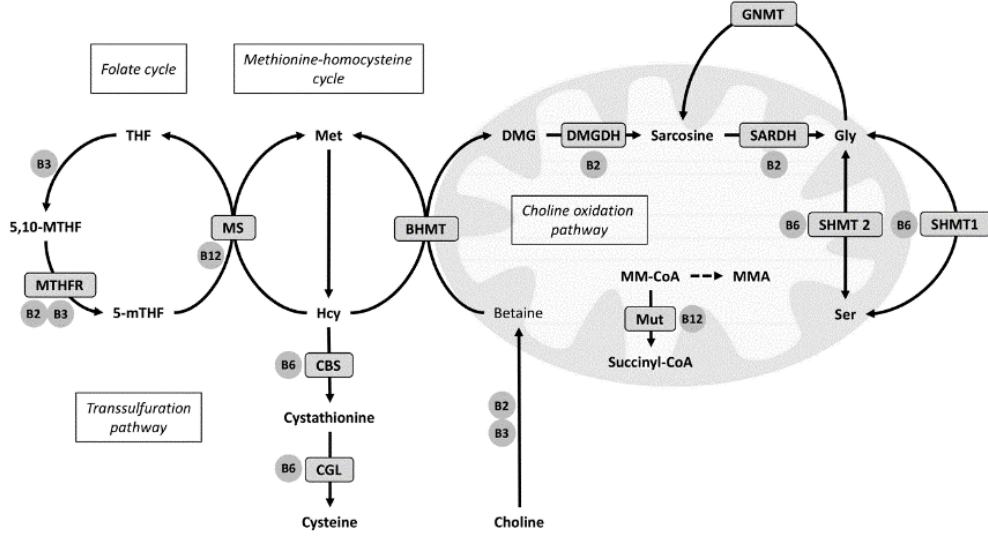
Figure 1. Overview of one-carbon metabolism related pathways. 5-mTHF indicates Overview of one-carbon metabolism related pathways. 5-mTHF